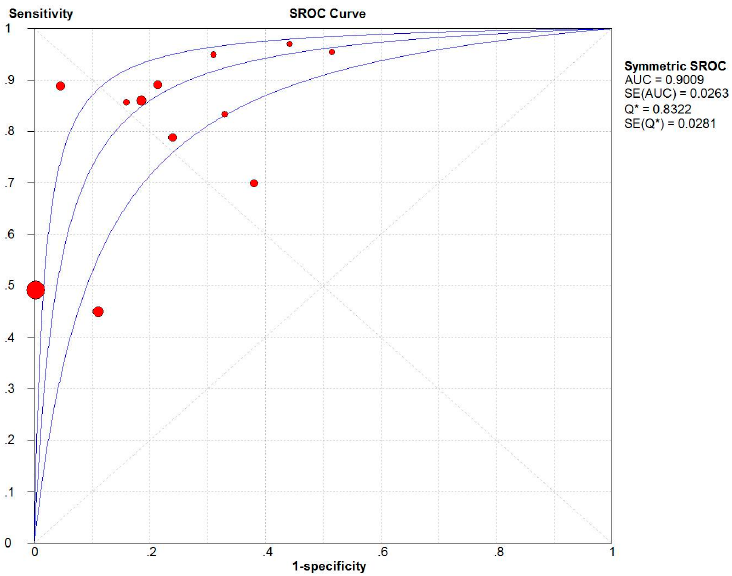
Figure 2. Summary receiver operating characteristics (SROC) curve of the Injury Severity Score (ISS). AUC is the area under the receiver operator characteristic (ROC) curve.